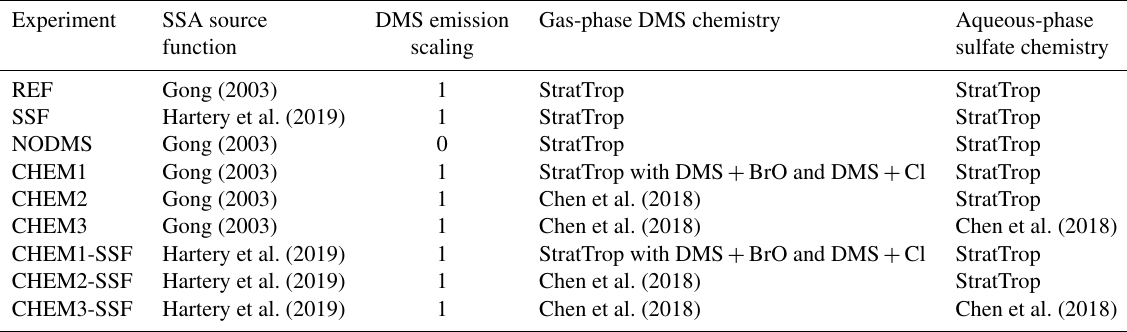
Table 2. HadGEM3-GA7.1-mod simulations performed. Experiment SSA source DMS emission Gas-phase DMS chemistry Aqueous-phase function scaling sulfate chemistry REF Gong (2003) 1 StratTrop StratTrop SSF Hartery et al. (2019) 1 StratTrop StratTrop NODMS Gong (2003) StratTrop with DMS + BrO and DMS + Cl StratTrop CHEM2 CHEM1-SSF Hartery et al. (2019) 1 StratTrop with DMS + BrO and DMS + Cl StratTrop CHEM2-SSF Hartery et al. (2019)